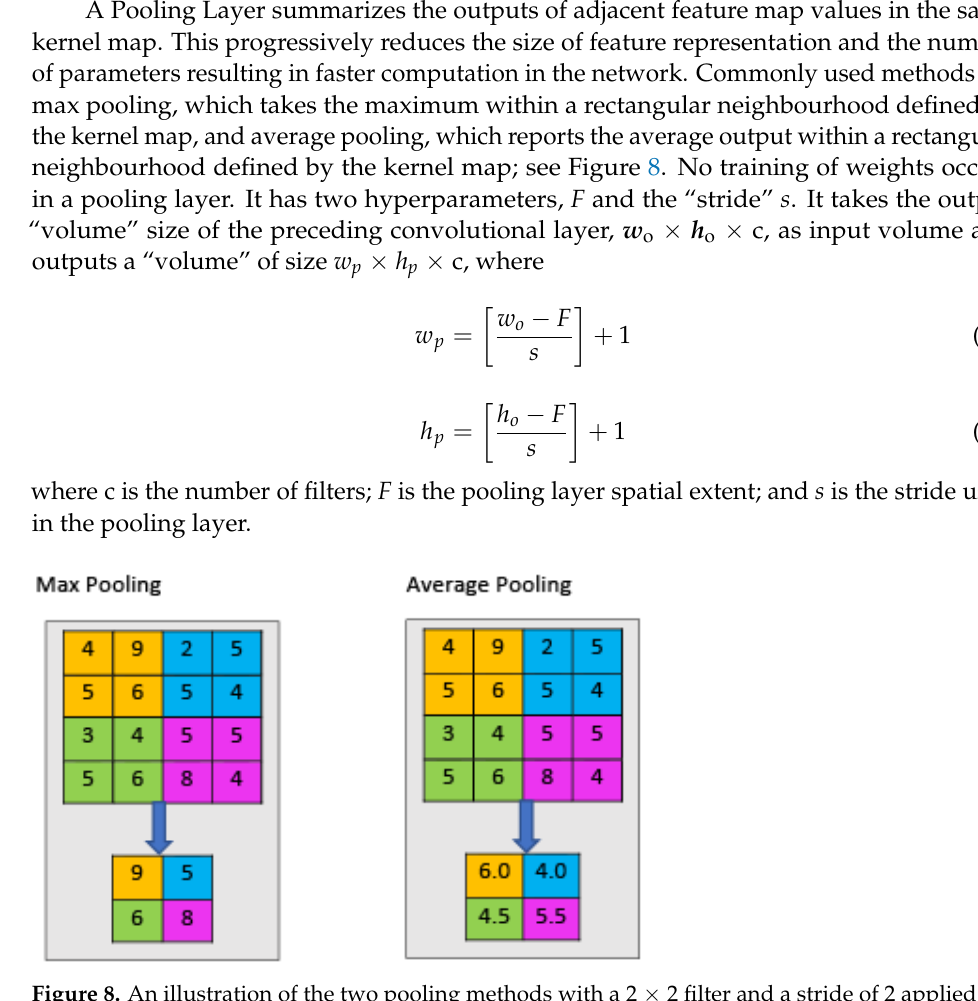
Figure 8. An illustration of the two pooling methods with a 2 × 2 filter and a stride of 2 applied. The Fully Connected Layer is just a regular perceptron artificial neural network as described in section B2 (i) above. It takes the unrolled or flattened “volume” from the last convolutional or pooling layer as its input.